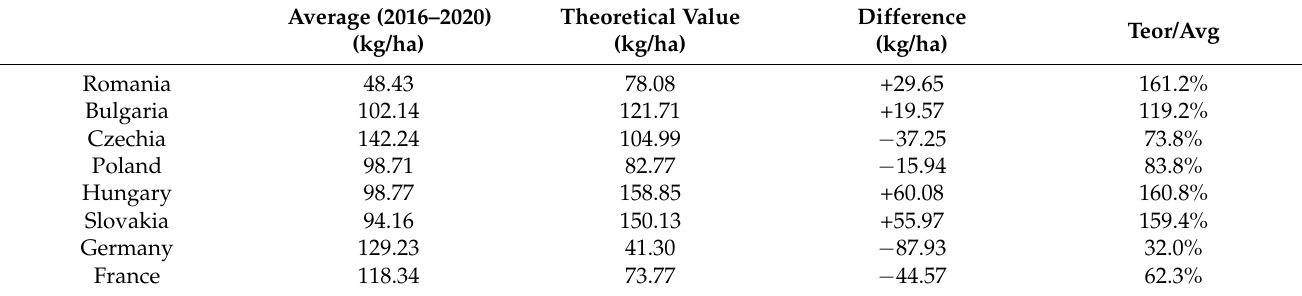
Table 3. Calculation of the maximum theoretical mineral nitrogen fertiliser consumption (in kg/ha of arable land in nitrogen value). Source: own calculation based on